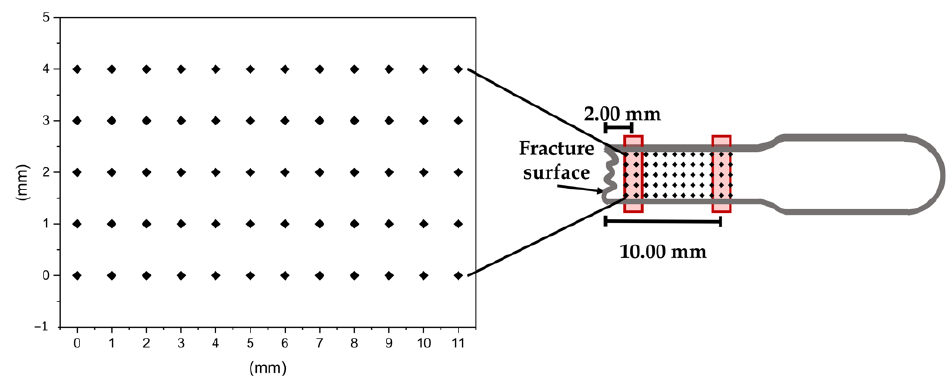
Figure 2. Schematic illustration of Vickers microhardness matrix in the top view fractured tensile specimen.